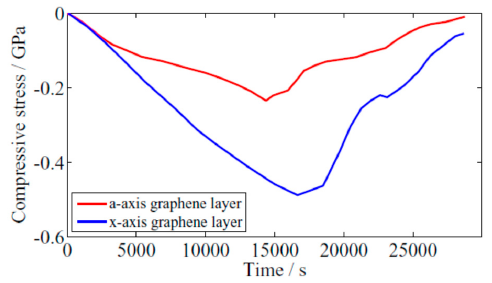
Figure 7. Graphite electrode stresses at a -axis and c -axis orientation graphene layer [33,34].